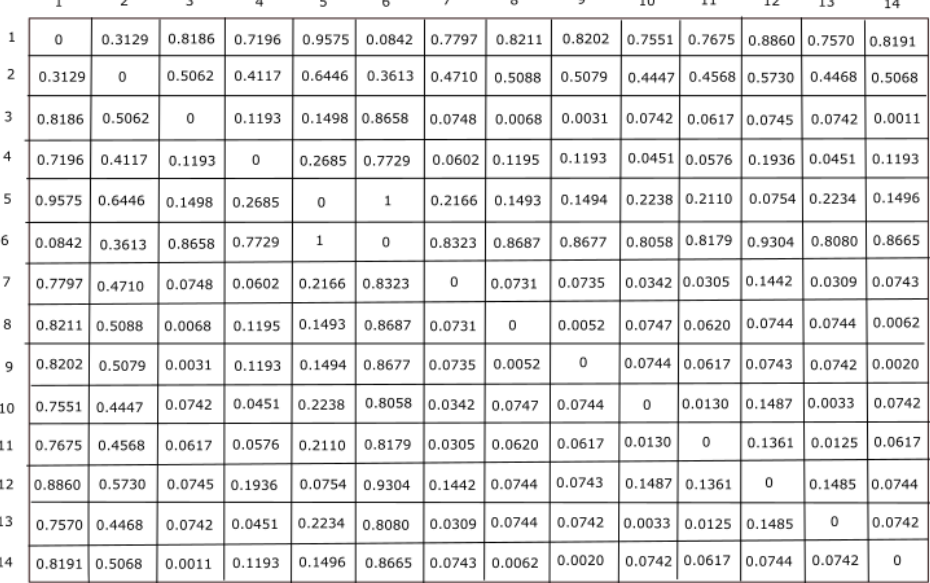
Figure 2. Distance matrix of all species derived using Euclidean distance. The numbers on the top and left denote the protein sequence ID (see Table 1).